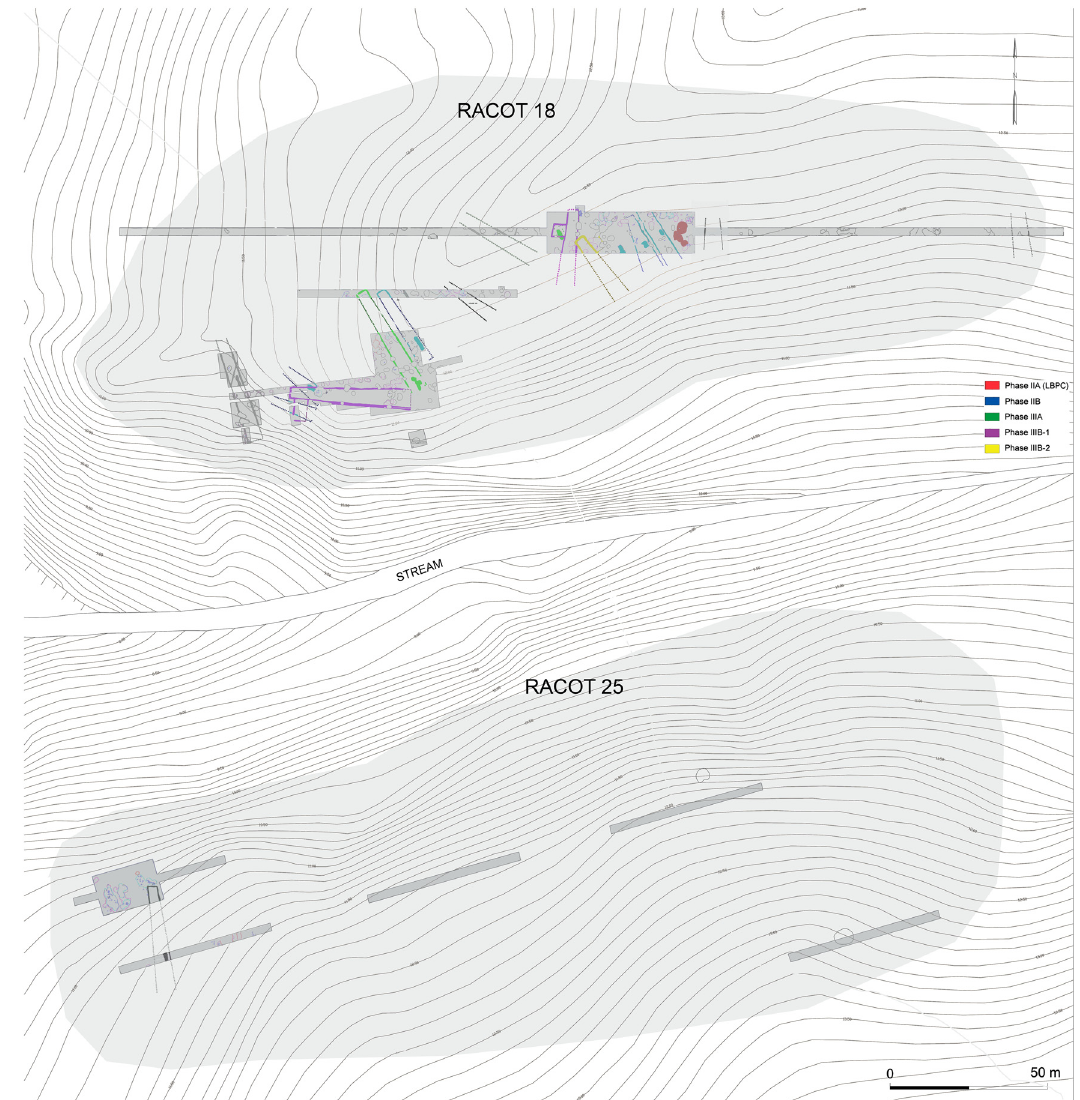
Figure 2: Schematic plan of Racot 18 and Racot 25 and plan of Racot 18 showing site phasing and house - plans ( after Czerniak et al., 2016, Figure 2 )